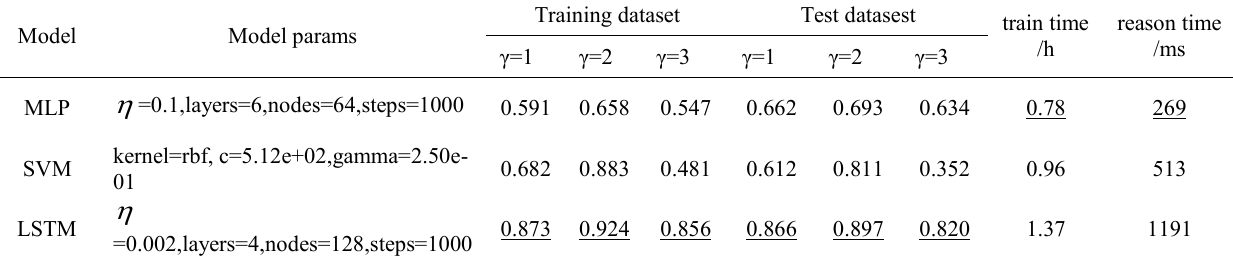
Table 1 Comparison of prediction accuracy of different